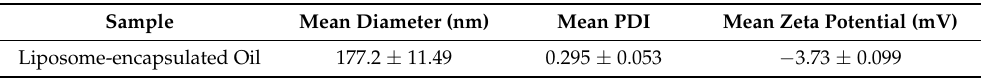
Table 2. Mean diameter, PDI and Zeta potential of liposome-encapsulated L. angustifolia oil.